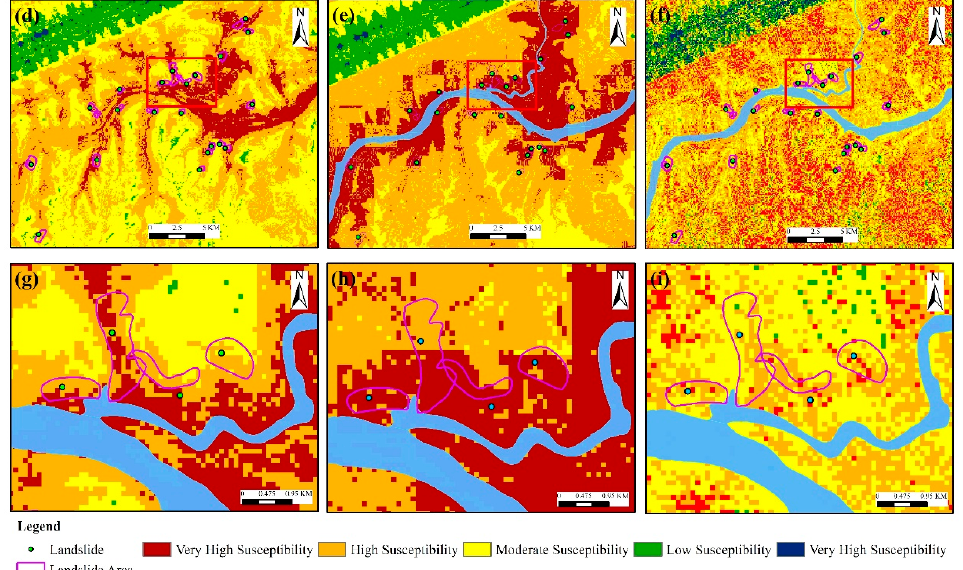
Figure 11. Typical landslides in the Three Gorges Reservoir area: ( a ) Yunyang County (high- susceptibility area, 2017.06). ( b ) Yunyang Country (moderate-susceptibility area, 2021.08). ( c ) Wanzhou District (low-susceptibility area, 2021.07). Typical landslide susceptibility analysis results: ( d ) LR analysis results. ( e ) RF analysis results. ( f ) SVM analysis results. Typical local landslide results: ( g ) local results of LR, ( h ) local results of RF, and ( i ) local results of SVM.